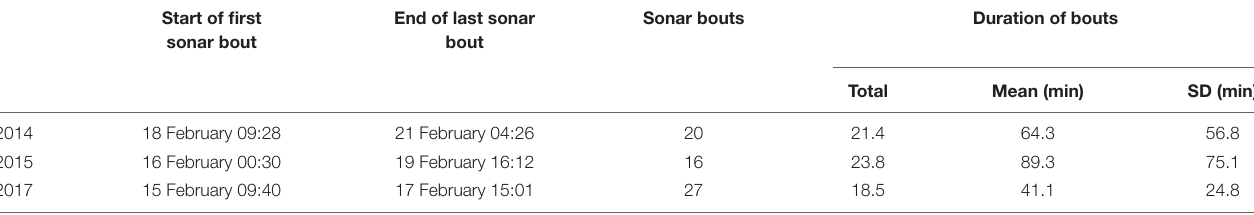
TABLE 2 | Start and end of survey period in each year, the number of tracks overlapping with each sonar exposure phase (columns headed “Baseline” to “After”) and the number of unique tracks per study year (“Total”). Start End Baseline Before During Between After Total